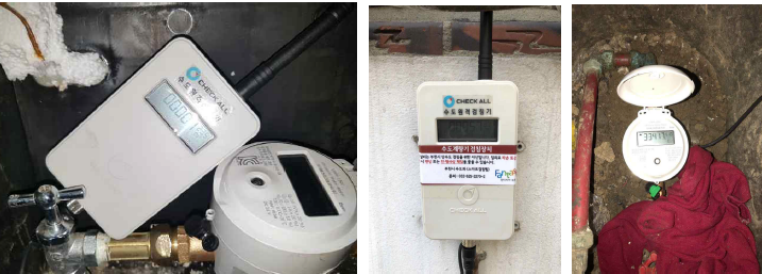
Figure 2. The left is the RWMR device installed in the household. The center is the AMI remote meter reader and the right is the water meter for remote meter